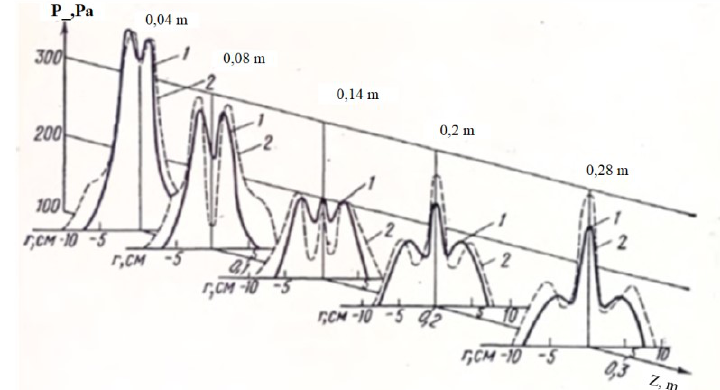
Fig. 2. Experimental (curves 1) and calculated (curves 2) transverse distributions of the difference frequency